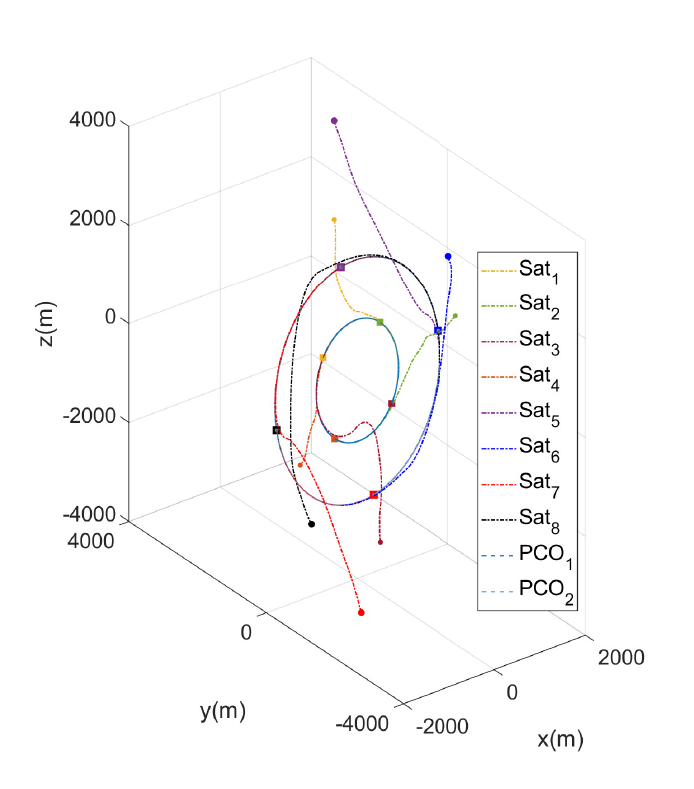
Figure 13. PBC law. Plot of 3D